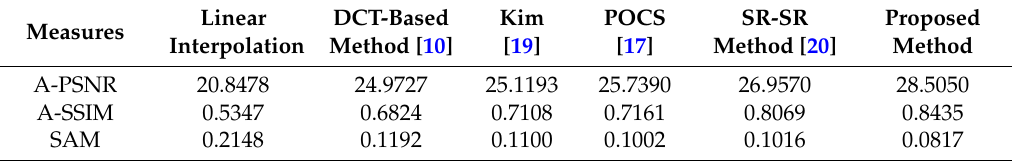
Figure 4. False color image of experimental results for the PaviaU dataset (color composite of R: 80, G: 28, B: 9). ( a ) original HR image; ( b ) linear interpolation results; ( c ) DCT-based method [10] results; ( d ) Kim [19] results; ( e ) POCS [17] results; ( f ) SRSR [20] results; ( g ) proposed APOCS-BM method results. Table 1. Comparison results of A-PSNR, A-SSIM and SAM on the PaviaU